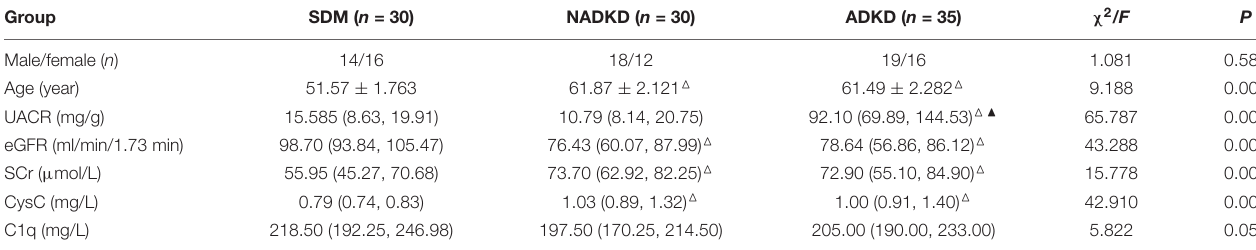
TABLE 1 | Clinical data of subjects ( n =